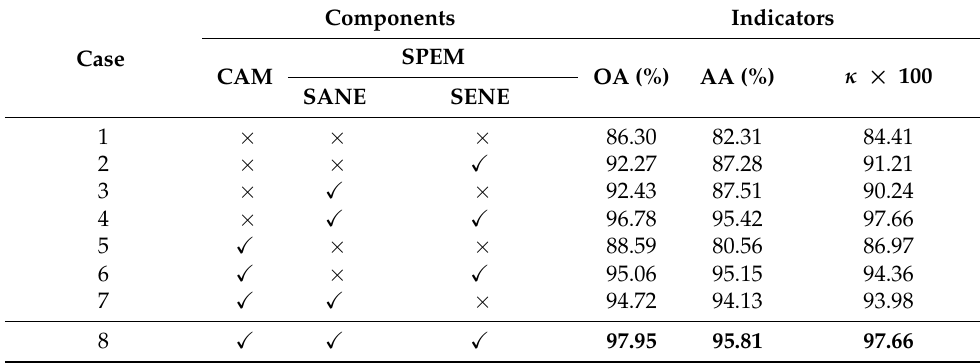
Table 4. Ablation Analysis of The Components on Indian Pines Data Set.